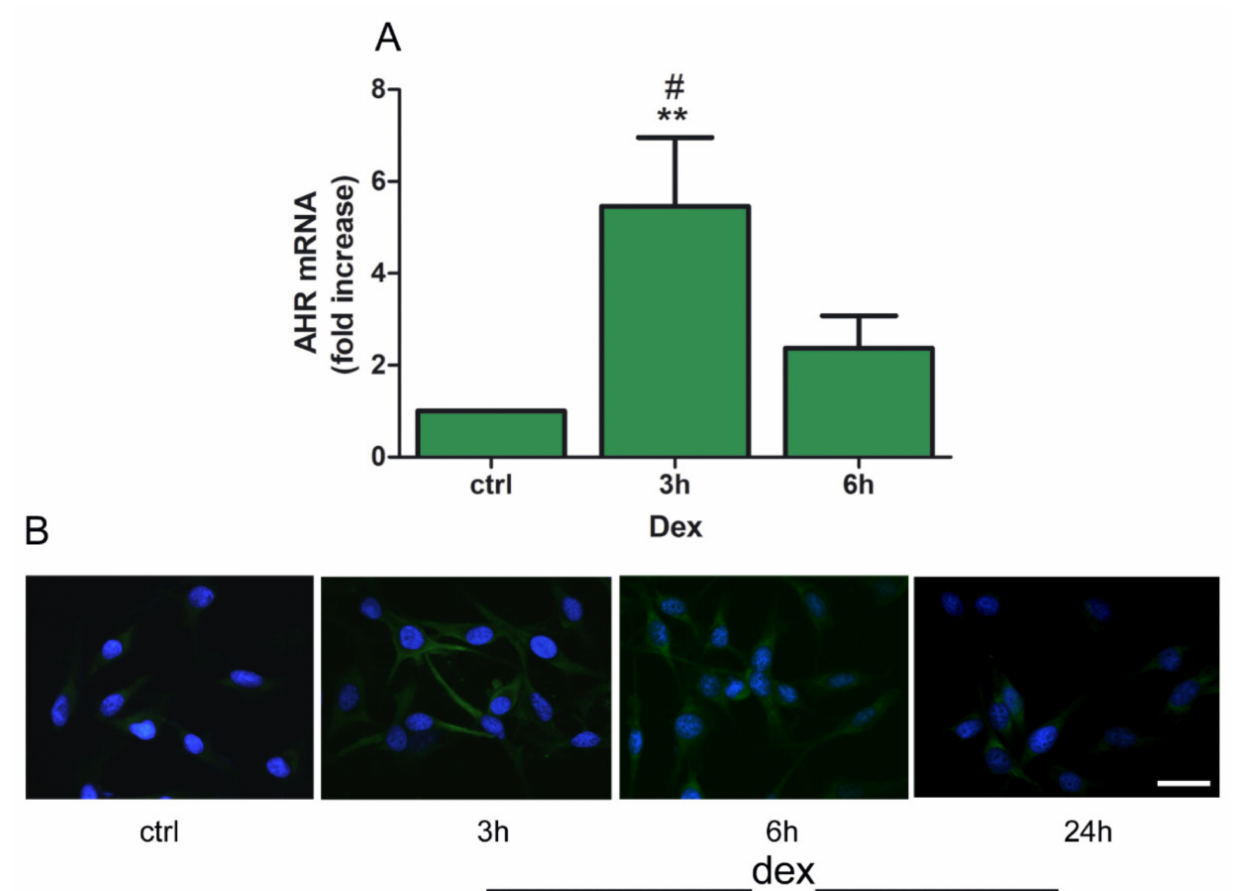
Figure 4. Dex modulates aryl hydrocarbon receptor (AHR) expression. ( A ) Cells were treated without (ctrl) or with dex (25 µ M) for 3 and 6 h. Total RNA was then isolated, and real time PCR was performed. Data represent mean ± SEM, ( n = 5; ** p < 0.001 vs. control unstimulated (ctrl) cells; # p < 0.05 vs. dex 3 h. ( B ) Cells were treated without (ctrl) or with dex (25 µ M) for 3, 6, and 24 h followed by immunofluorescence for AHR expression (AHR: green; nuclei: blue). Representative photomicrographs at 40 × magnification are shown. Scale bar 20 µ